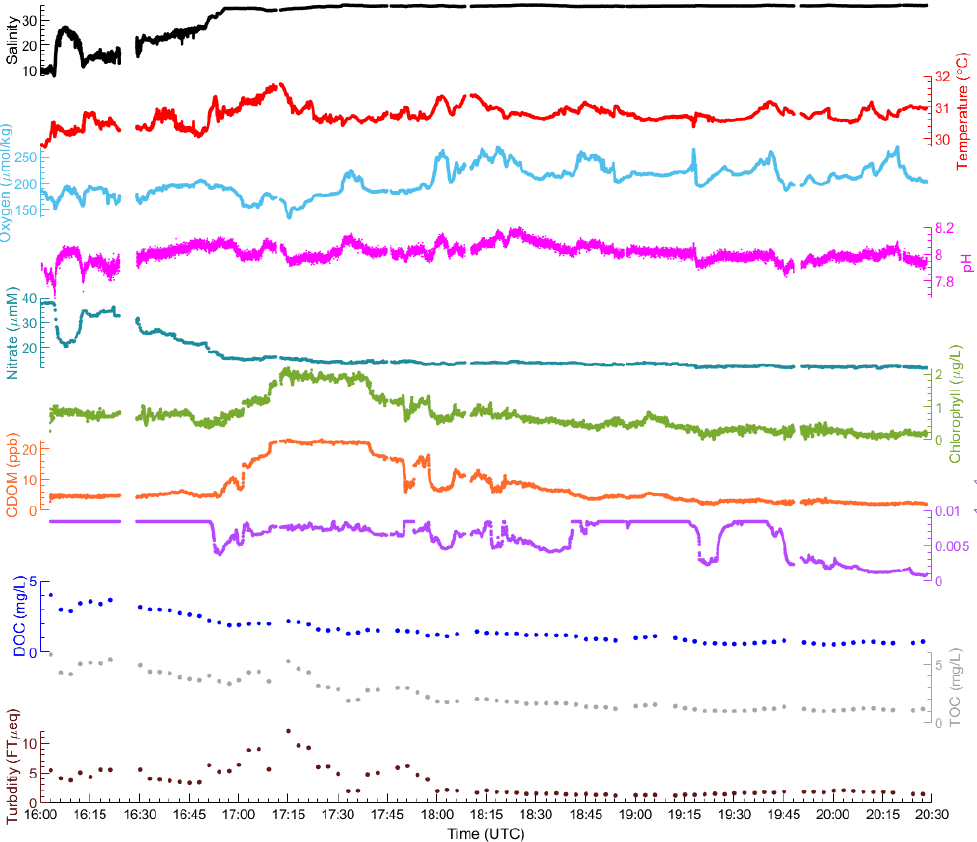
Figure 8. Biogeochemical parameters collected concurrently with pH to evaluate controls on ocean acidification. Different panels show an example 4.5 h window of the different parameters: Salinity (black), Temperature (red), Dissolved Oxygen (DO, light blue), pH (pink), Nitrate (teal), chlorophyll concentration (green), coloured dissolved organic matter (CDOM, orange), optical backscatter (purple), dissolved organic carbon (DOC, dark blue), total organic carbon (TOC, grey), and Turbidity (brown). All data have been factory calibrated. Further corrections have been applied to DO (corrected for salinity, temperature, and pressure using CTD data), and pH (corrected for temperature). Salinity, Temperature, DO, pH, Nitrate, Chlorophyll, CDOM, Backscatter, and pH data have all been smoothed with an 11-pt moving median. Further details on the sensors measuring these parameters can be found in Table 1.